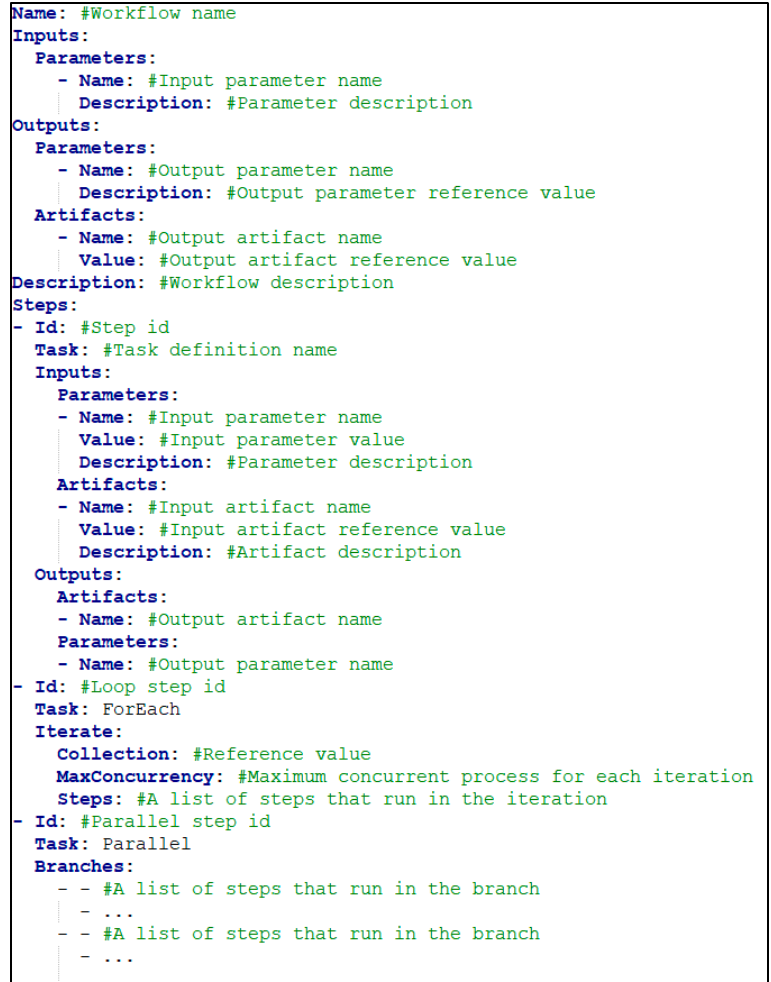
Figure 4. Workflow definition